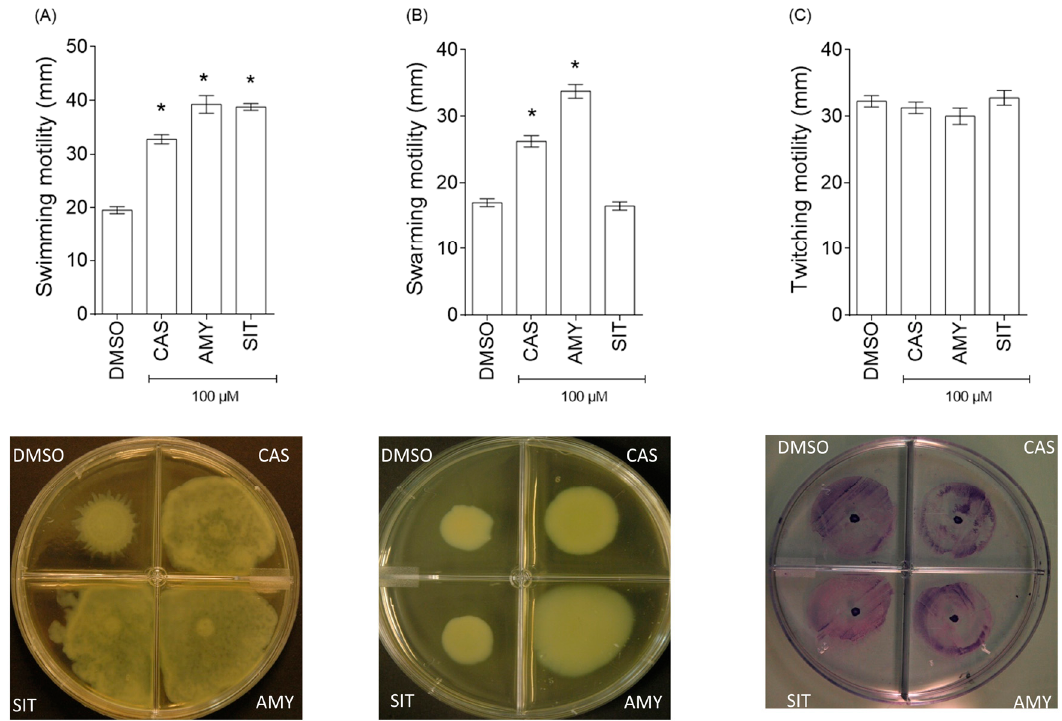
Figure 10. Effect of cassipourol, β -sitosterol and α -amyrin on P. aeruginosa PAO1 motilities. ( A ) Swimming motility of P. aeruginosa PAO1 onto LB agar (0.3%) supplemented with DMSO (1%) or cassipourol (CAS, 100 µM), β -sitosterol (SIT, 100 µM) or α -amyrin (AMY, 100 µM); ( B ) Swarming motility of P. aeruginosa PAO1 onto LB agar (0.6%) supplemented with glutamate (0.05%), glucose (0.2%) and DMSO (1%) or cassipourol (CAS, 100 µM), β -sitosterol (SIT, 100 µM) or α -amyrin (AMY, 100 µM). After incubation at 37 °C for 24 h, the zones of migration (down) from the point of inoculation were measured (up) for each condition; and ( C ) Twitching motility of P. aeruginosa PAO1 onto LB agar (1%) supplemented with DMSO (1%) or cassipourol (CAS, 100 µM), β -sitosterol (SIT, 100 µM) or α -amyrin (AMY, 100 µM). The twitching zones were stained (down) and their diameters (up) measured after incubation at 37 °C for 48 h. Error bars represent the standard errors of the means and all experiments were performed in quintuplicate with three independent assays and asterisks indicate samples that are significantly different from the DMSO (One-way ANOVA followed by Dunnett’s test of multiple comparisons; p < 0.01).